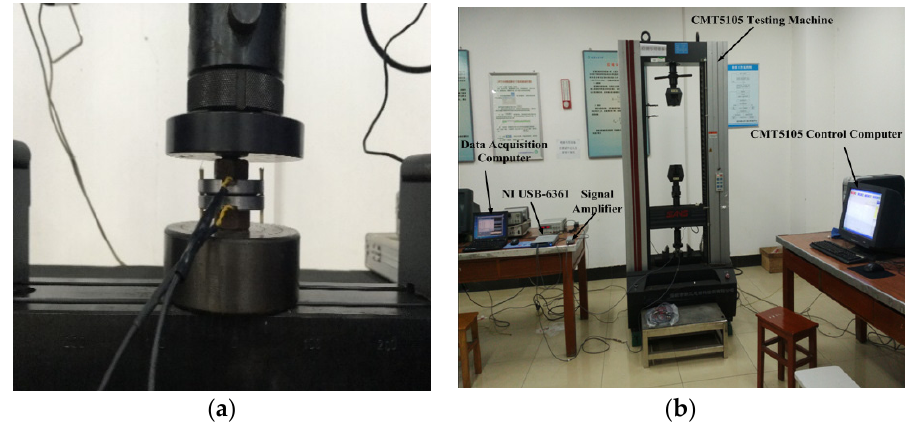
Figure 6. The experimental setup: ( a ) Smart washers on the test fixture; ( b ) Entire setup.